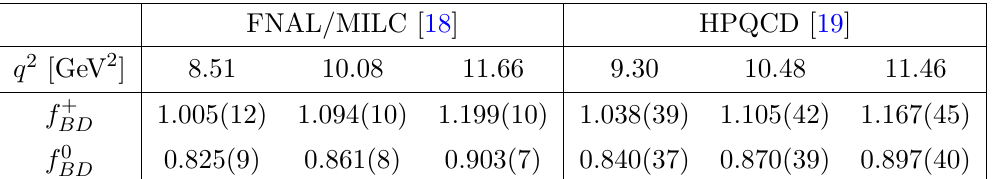
Table 4 . Lattice QCD predictions of the form factors used in the BGL fit.